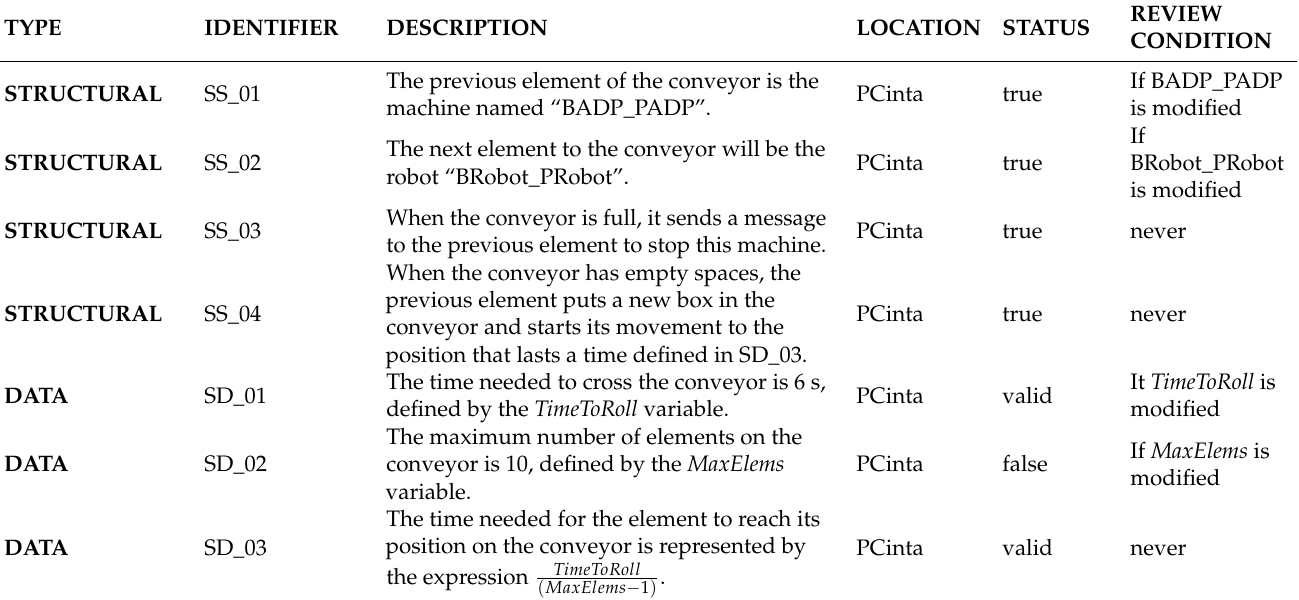
Table 5. Assumptions table. The TimeToRoll variable is not yet validated on this iteration; hence all the assumptions that are related to it are considered valid but not true. In this iteration, we also detect that the maximum number of elements that can be on a conveyor is not 10; hence SD_02 is false; we must go to the factory and measure the new number of elements that can be on the conveyor.